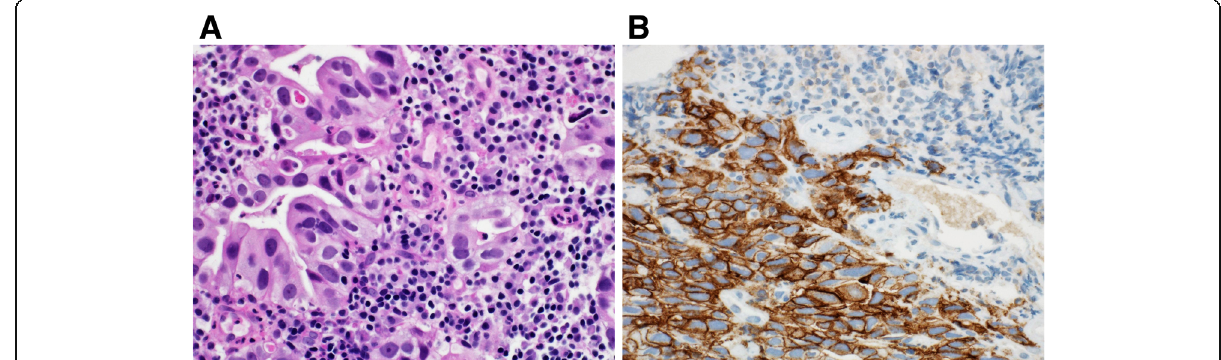
Fig. 14 A Case of moderately differentiated gastric adenocarcinoma. B immunohistochemical staining of the tumor in which only tumor cells are positive for PD-L1; while tumor immune cells are negative. CPS: 80. (DAKO 22C3 antibody)